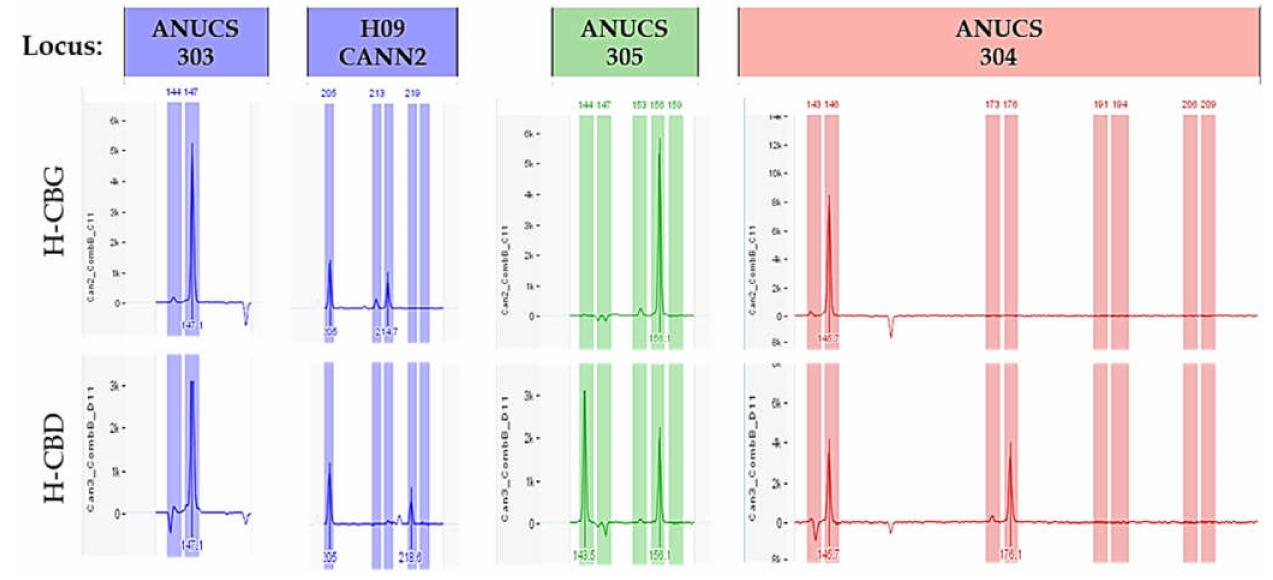
Figure 5. Depending on the genotype of each variety and the genetic locus, the plants showed homozygosity (H-CBG plant sample, loci: ANUCS 303, ANUCS 305, and ANUCS 304; H-CBD plant sample, locus ANUCS 303) or heterozygosity (H-CBG plant sample, locus: H09 CANN2; H-CBD plant sample, loci: H09 CANN2, ANUCS 305, and ANUCS 304). Micropropagated and regenerated plants showed no differences as compared with the mother plant in the SSR analysis. After 4 weeks of culture under environmental conditions, no SSR polymorphism was observed between donor genotypes and their plantlets. All primers presented standard allele patterns, regardless of the two in vitro culture methodologies. The genotyped in vitro cultured samples generated the same SSR profile to the original mother plant, i.e., the same alleles for all loci tested (Figure 6). Based on PCR assays for the 12 SSR primers used, no somaclonal variation was detected between the donor genotype and the in vitro cultured plants for each variety (Figure 7). Moreover, the general visual morphology of the acclimatized plants was also similar to mother plants.